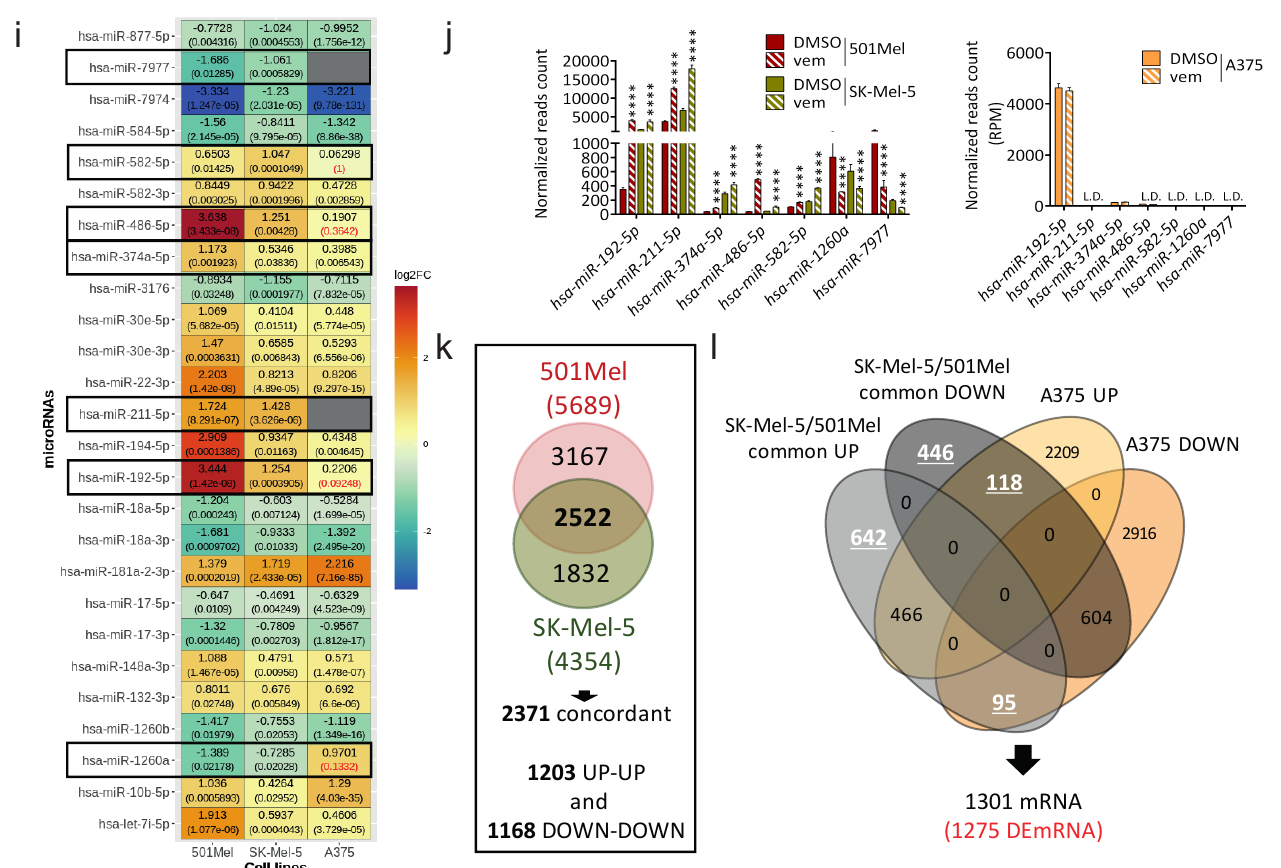
Figure 1. DEmiRs and DEmRNAs in vem-treated pigmentable 501Mel and SK-Mel-5 cells vs. non- pigmentable A375 cells. ( a – c ) mRNA level (( a ), CCLE data (https://sites.broadinstitute.org/ccle/ (accessed on 31 August 2022)): left , single genes; right , grouped genes); ( b ), qRT-PCR) and protein level (( c ), Western blot) of genes involved in melanin synthesis, as detected in pigmentable melanoma cells (501Mel (dark red) and SK-Mel-5 (olive green)) and in non-pigmentable A375 melanoma cells (orange). ( d , e ) Representative images ( d ) and quantification ( e ) of melanosomes detected by TEM in A375 and 501Mel cells. Scale bar: 1 µ m. The graph represents the mean ± SEM of 3 independent experiments. ( f ) Representative images of cell pellets after 72 h of treatment of A375 ( top ), 501Mel ( middle ) and SK-Mel-5 cells ( bottom ) with DMSO or 2 µ M vem. Unlike non-pigmentable A375 cells, pigmentable 501Mel and SK-Mel-5 cells are characterized by vem-induced darkening. ( g ) Cartoon of the experimental workflow that has been followed to obtain NGS data. ( h ) ( left ) Number of up- and down-regulated miRNAs in A375 (orange), 501Mel (dark red) and SK-Mel-5 (olive green). ( right ) Venn diagram of cell line-specific and common DE miRNAs in the three cell lines. ( i ) Heatmap of the 26 DE miRNAs shared by 501Mel and SK-Mel-5 pigmentable melanoma cells. Nineteen are shared by A375 cells as well, while seven DEmiRs (highlighted with black rectangles) are not: miR-192-5p, miR-211-5p, miR-374a-5p, miR-486-5p and miR-582-5p are up-regulated in vem compared to DMSO; miR-1260a and miR-7977 are down-regulated in vem compared to DMSO. The adjusted p -value is reported below each log2FC value. ( j ) Normalized reads count of miR-192-5p, miR-211-5p, miR- 374a-5p, miR-486-5p, miR-582-5p, miR-1260a and miR-7977 DEmiRs, after 48 h of treatment with DMSO or 2 µ M vem. Dark red: 501Mel cells; olive green: Sk-Mel-5 cells; orange: A375 cells. ( k ) Venn diagram of cell line-specific and common DE RNAs in 501Mel and SK-Mel-5 cells. ( l ) Venn diagram of RNAs differentially expressed in a concordant or discordant way in 501Mel plus SK-Mel-5 cells (grey ovals) vs. A375 cells (orange ovals). Pigmentable melanoma cell line-specific DEmRNAs are 1275. ** p < 0.01, **** p <